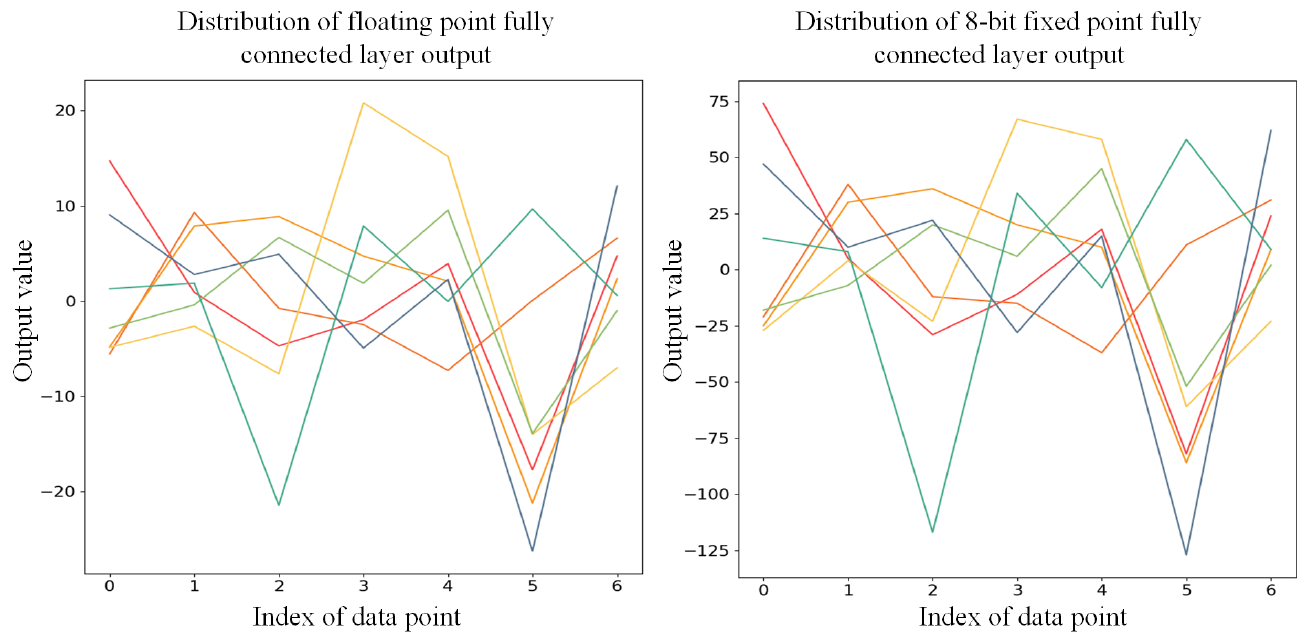
Figure 7. The input and output distribution of 7 classes of Chinese medicinal materials in OI-DSCNN. The left side of each subfigure is the distribution of OI-DSCNN at the floating point. The right side of each subfigure is the distribution of OI-DSCNN at an 8-bit fixed point.